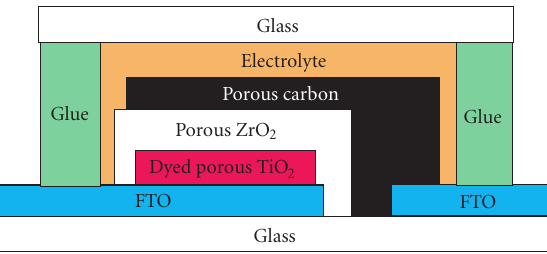
Figure 1: Structure of monolithic DSC.